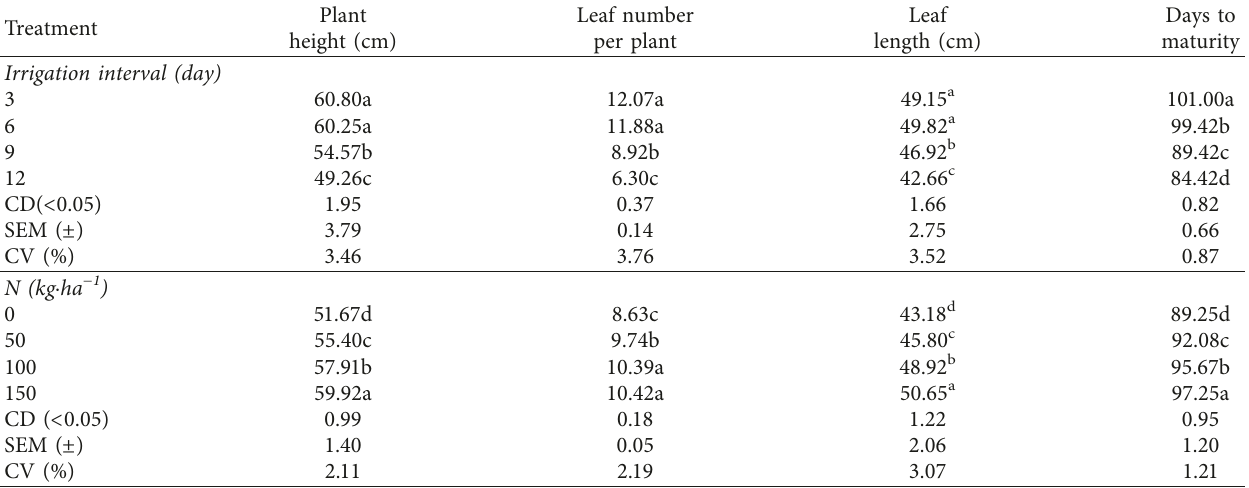
Table 3: Effect of the irrigation interval and N rate on growth parameters of onion (main effects). Treatment